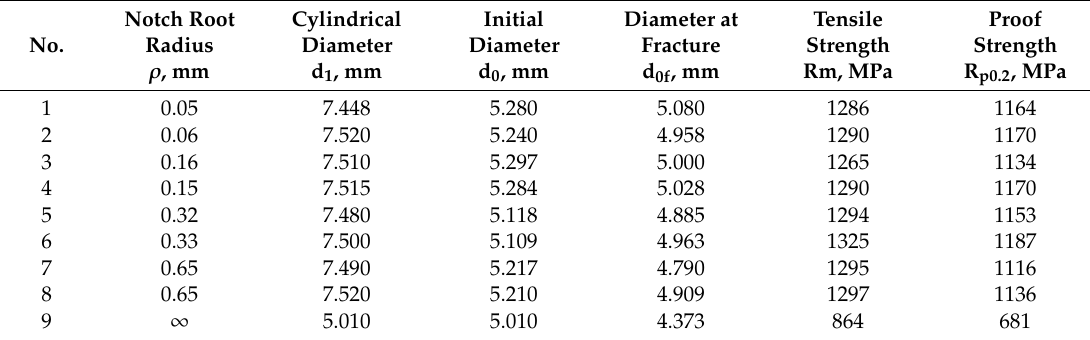
Table A1. Tensile test results on as-built material.